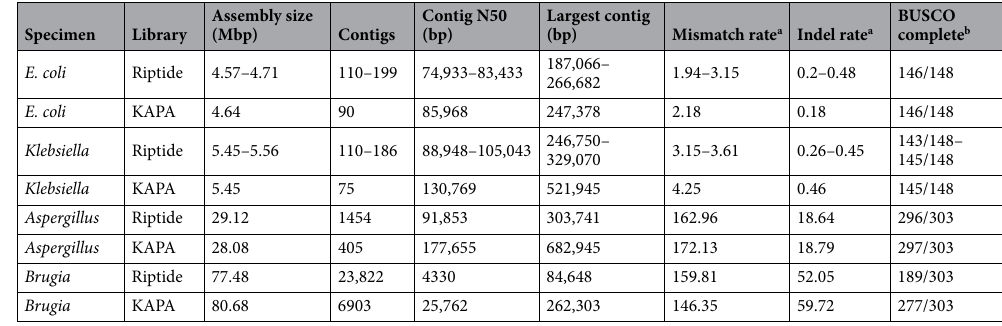
Table 2. Quantitative summaries of de novo assemblies. All statistics are shown for contigs > 1 kbp. Full results are available in Supplementary Data S1. a Mismatch rate and indel rates were calculated as the number of mismatches/indels in the assembled contigs relative to the reference genome per 100 kbp of aligned sequence. c BUSCO complete is the number of identified single copy + duplicated